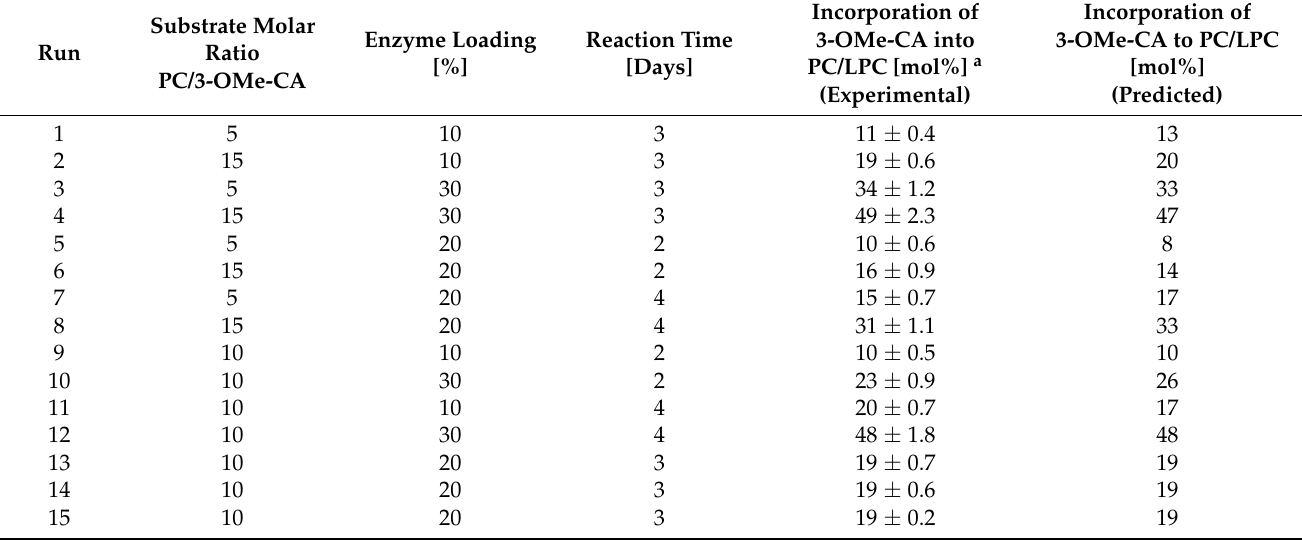
Table 1. Experimental design matrix for three independent variables of enzymatic acidolysis